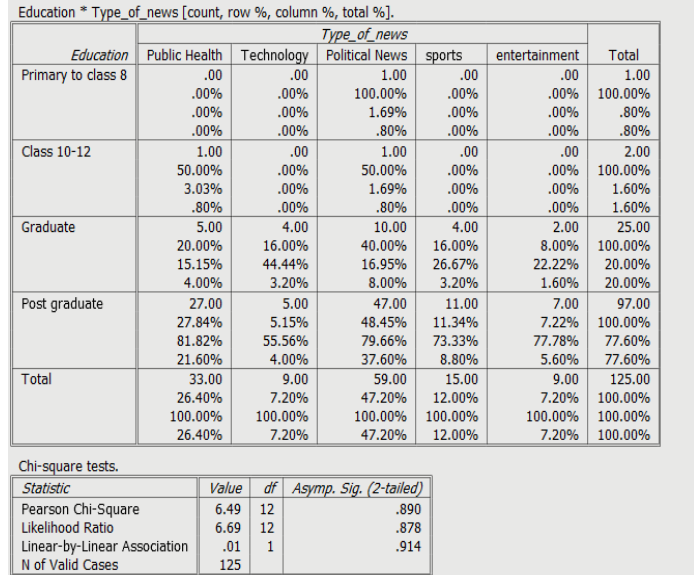
Figure 9: Cross tabulation and Chi-square between Education v/s Type of News Read (Source: Authors‟ depiction)